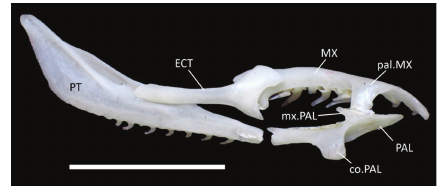
Figure 11: Dorsal view of the palatomaxillary complex of Sordellina punctata (IBSP 49404). Bar = 5mm. Abbreviations other than in previous figures are co.PAL: choanal process of palatine; mx.PAL: maxilar process of palatine; pal. MX: palatine process of maxilla.